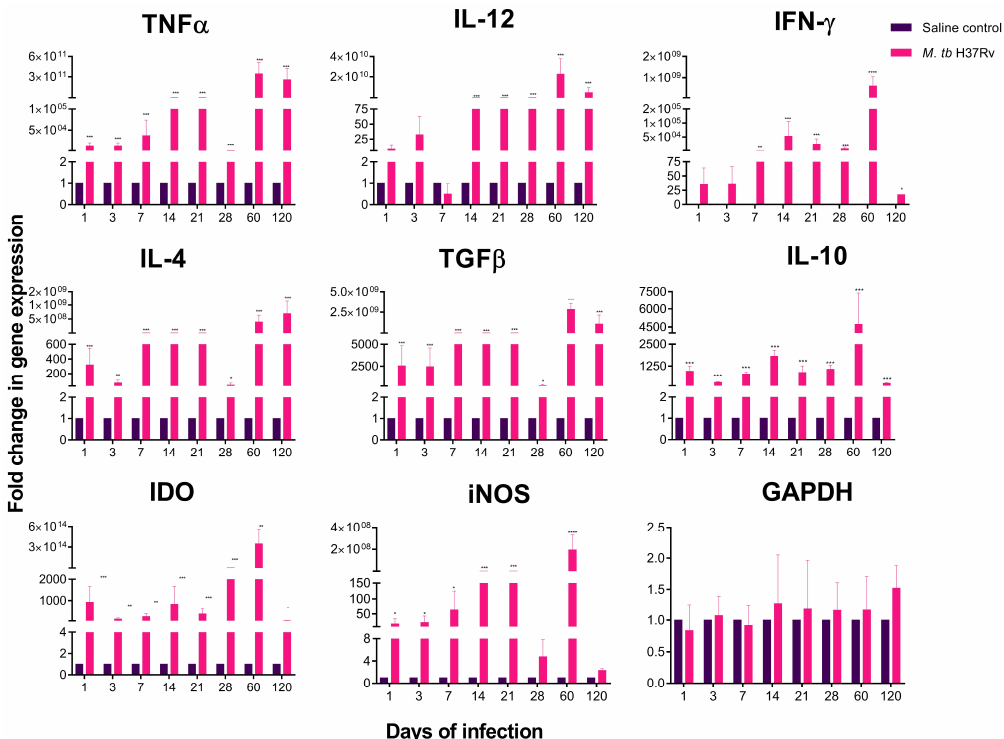
Figure 4. Cytokine and enzyme expression of the cerebellum of mice intratracheal infected with M. tb H37Rv. In the absence of any detectable brain infection, there was a significant increase in gene expression from day 1 post-infection with a peak on days 60 and 120. Saline controls were mainly una ff ected. RNA was isolated from cerebellum homogenates and reverse-transcribed to cDNA, then analysed for changes in gene expression determined by RT-PCR of the indicated cytokine or enzyme. Fold-change values were normalised to expression levels of the saline controls. Data are expressed as mean ± SEM. TNF α F (1, 10) = 68.02, p < 0.001, two-way ANOVA; *** p < 0.0001